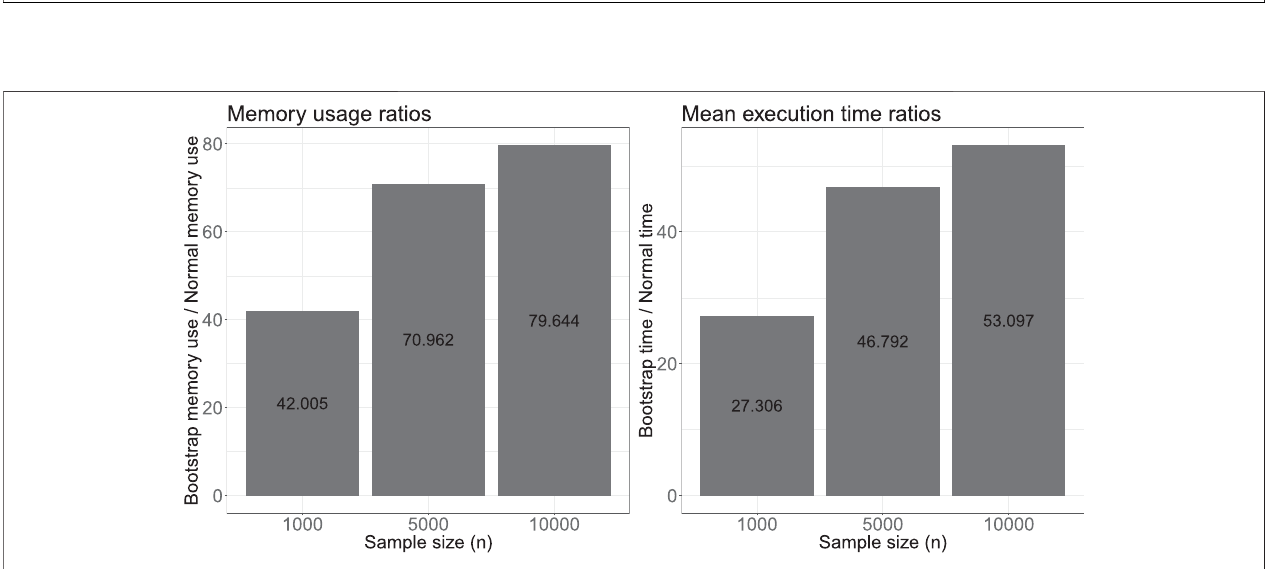
Frontiers in Applied Mathematics and Statistics |